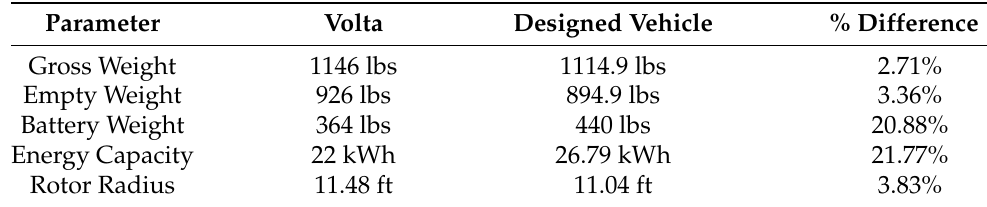
Table 3. Comparison of Volta [27] test aircraft to that designed using the current method.